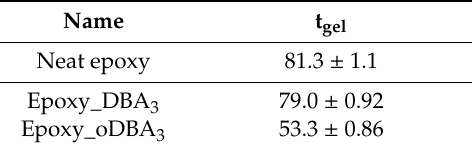
Table 3. Gel time ( t gel ) measured as the cross-point of the G' and G" curves of the neat resin and composite mixtures.